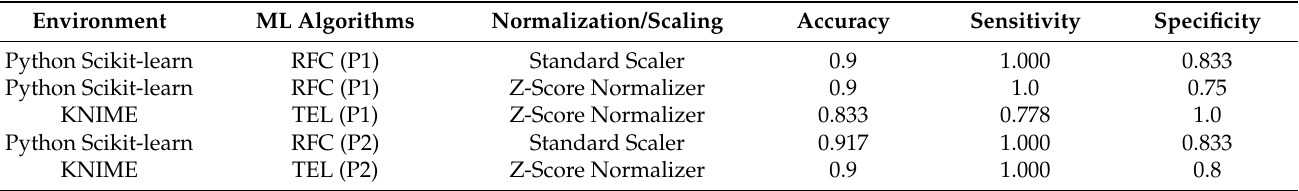
Table 2. General ML modeling performance metrics for the resistant and non-resistant CRC post- operative individuals’ group.